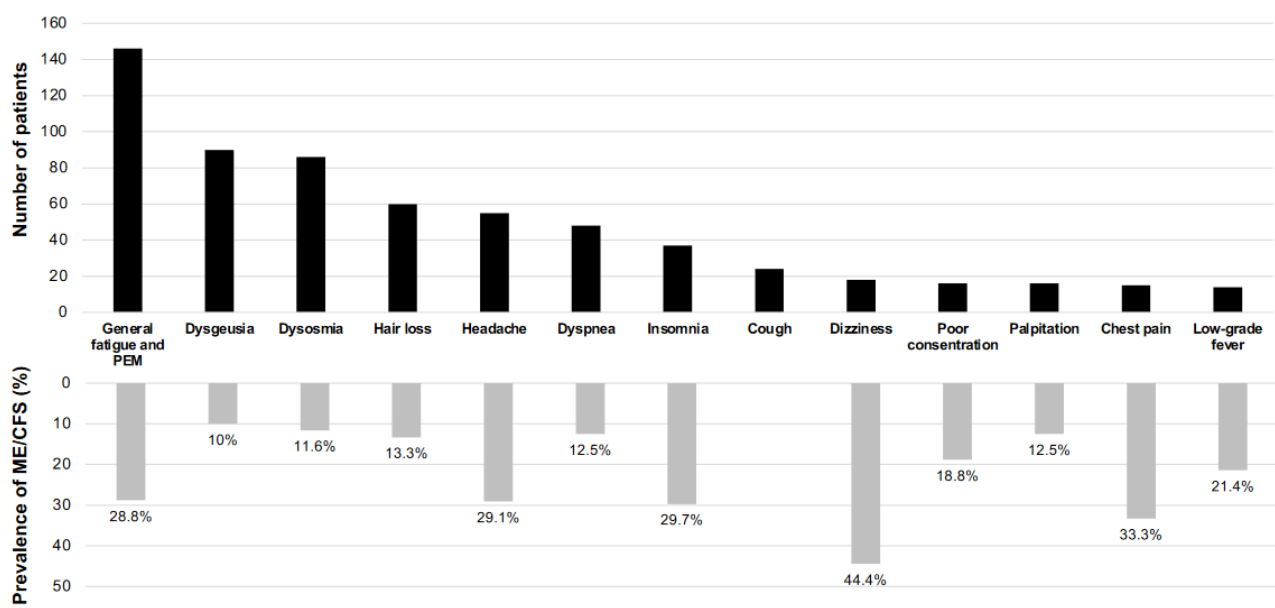
Figure 2. Relationships between major symptoms of long COVID and prevalence of ME/CFS. The upper panel shows the total number of major complaints in long COVID patients ( n = 279) and in lower panel shows the symptom-based percentages of patients who met the criteria of ME/CFS.